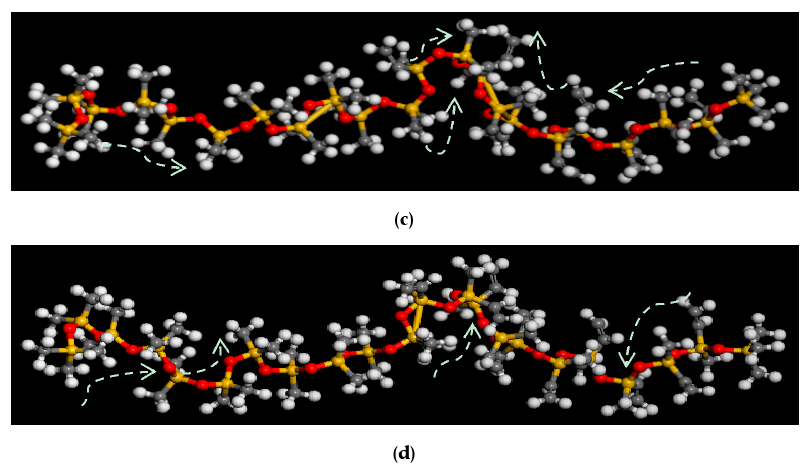
Figure 4. Structure changes of molecule chains during different electric fields. ( a ) The molecule in the 0.001 V/Å electric field; ( b ) The molecule in the 0.01 V/Å electric field; ( c ) The molecule in the 0.1 V/Å electric field; ( d ) The molecule in the 1 V/Å electric field.